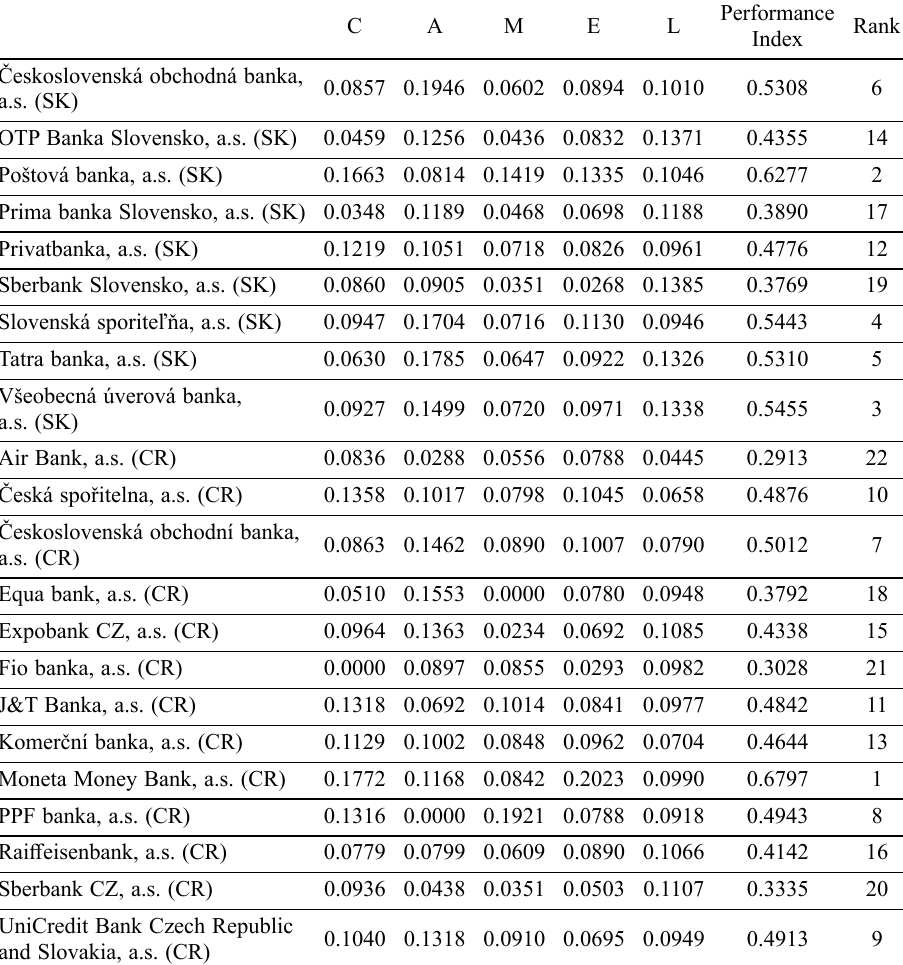
Table 3. Ranking of banks on the basis of an aggregated performance index C A M E L